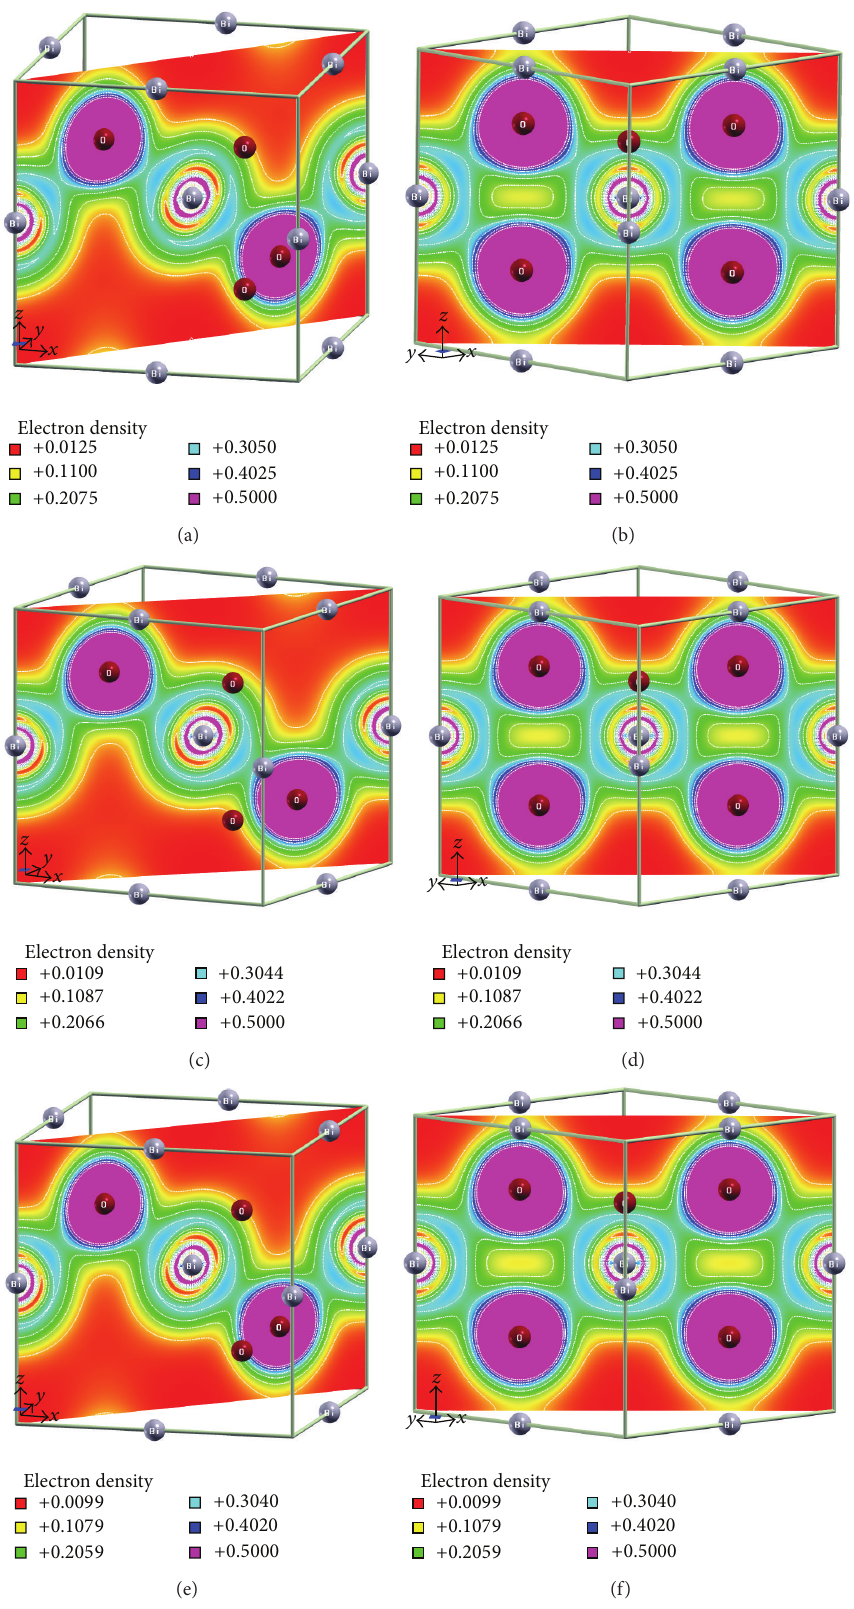
Figure 5: Charge density profile for 𝛿 -Bi 2 O 3 obtained by using LDA (a, b), B3PW91 (c, d), and PBE96 (e, f) exchange-correlation functionals. The charge profiles are plotted in (100) and (110) planes. Each atom has been identified with the corresponding chemical